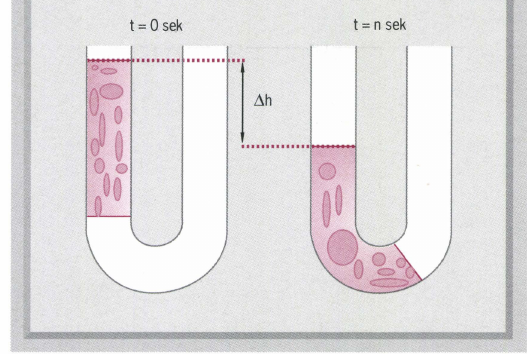
concrete suspensions